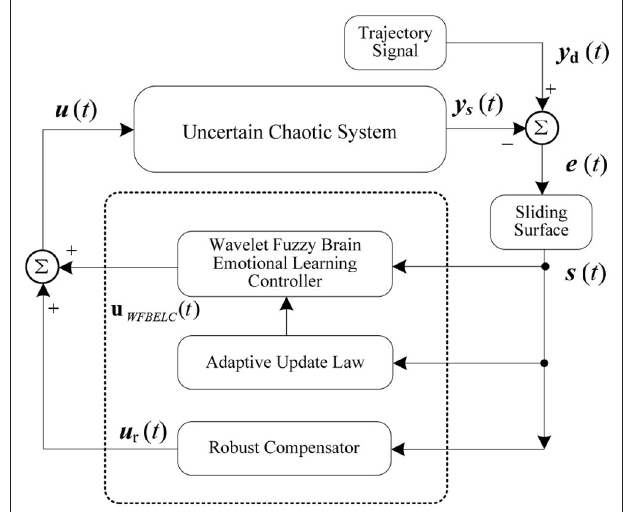
FIGURE 3 | Adaptive WFBELC control for uncertain chaotic system.